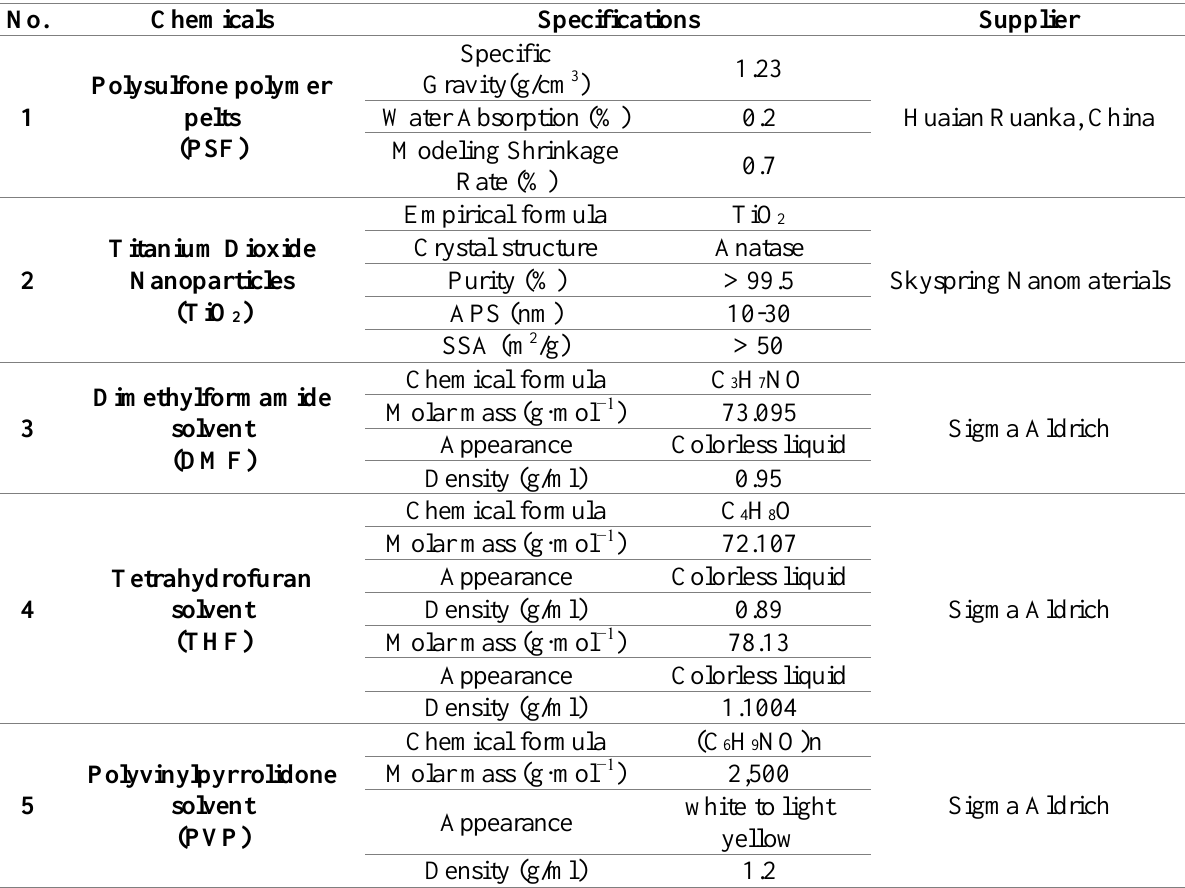
Table 1: The chemicals materials, specifications and suppliers.